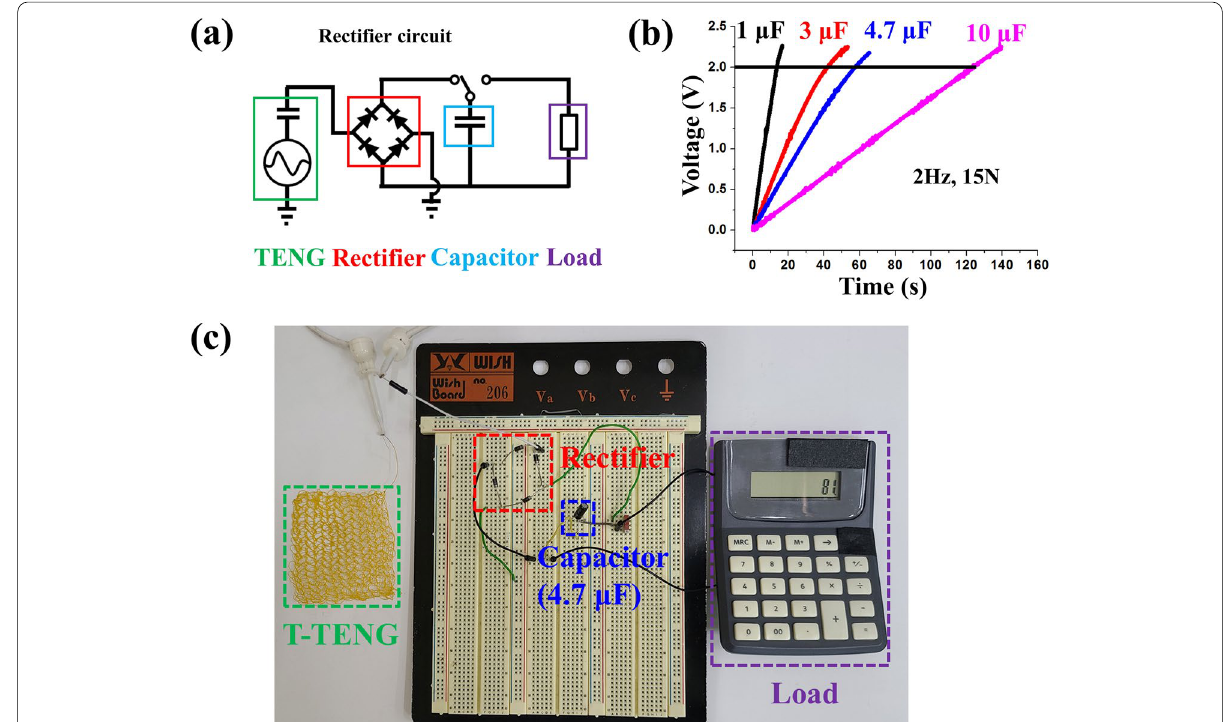
Fig. 4 a Circuit of charging capacitor using T‑TENG under periodic mechanical stimulation. The voltage–time relationship at different load capacitances using ( b ) Pushing machine and ( c ) Photograph of a working calculator using a charged